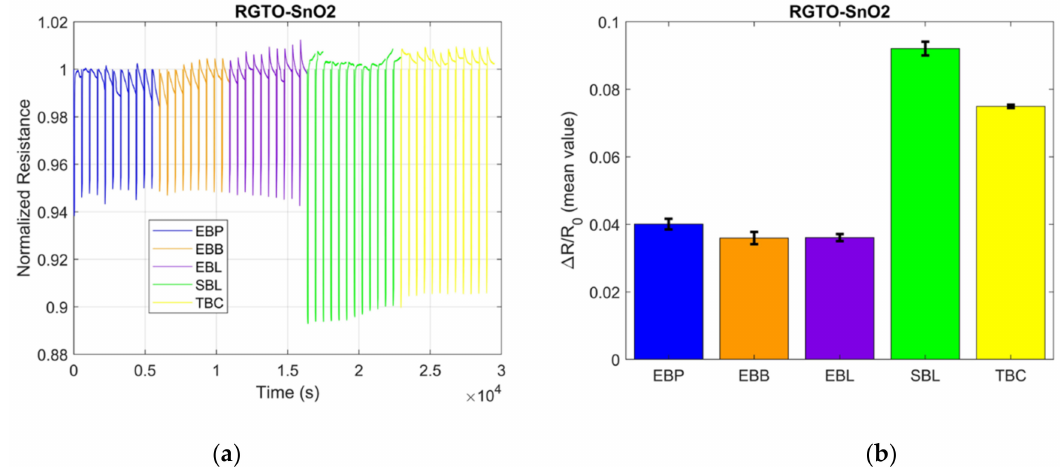
Figure 4. ( a ) Sensor response representation to the green teas RGTO sensor SnO 2 and ( b ) mean values for the ∆ R/R0 with the representation of the SD bar for the different green teas